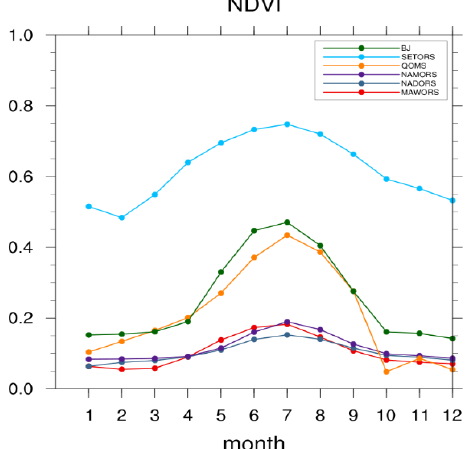
Figure 11. Annual variation of NDVI at each station.